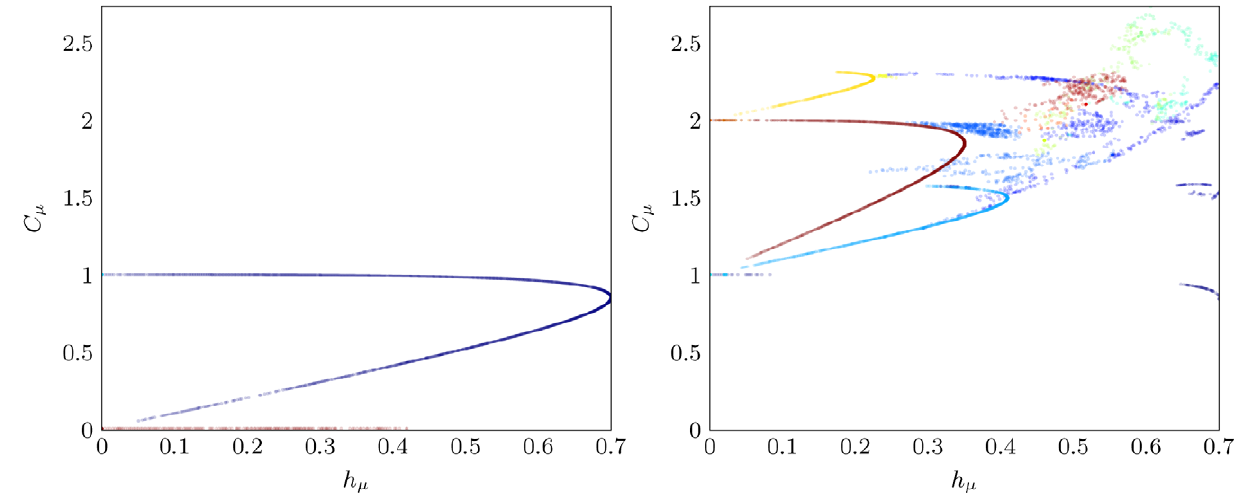
Figure 10. Complexity-entropy diagram for 30 realizations of the Golden Mean Process with N ~ 1000 , both without (left) and with (right) structural innovation. Alternating Process and Fixed Coin pathways are clearly visible in the left panel where the Golden Mean subspace exists on the upper curve and the Biased Coin subspace exists on the line C m ~ 0 . e -Machines within the same isostructural subspace have identical